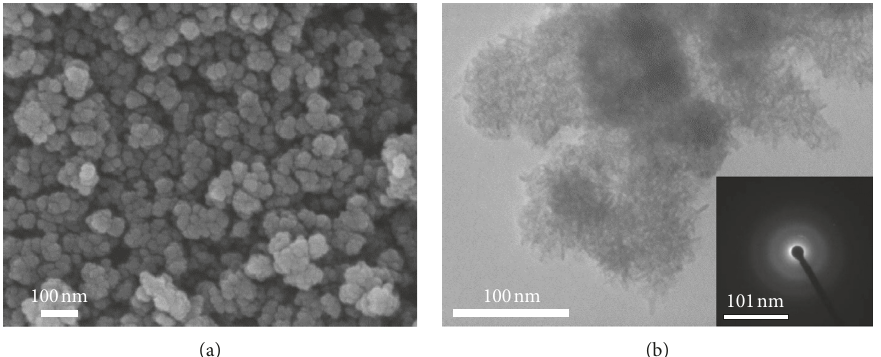
Figure 3: (a) FE-SEM image and (b) TEM image of as-synthesized MnO